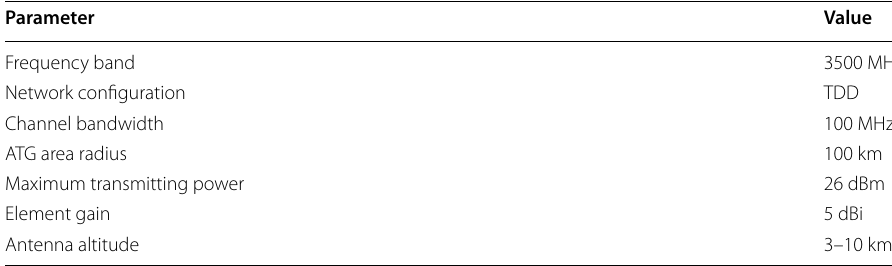
Table 1 ATG airborne terminal parameters